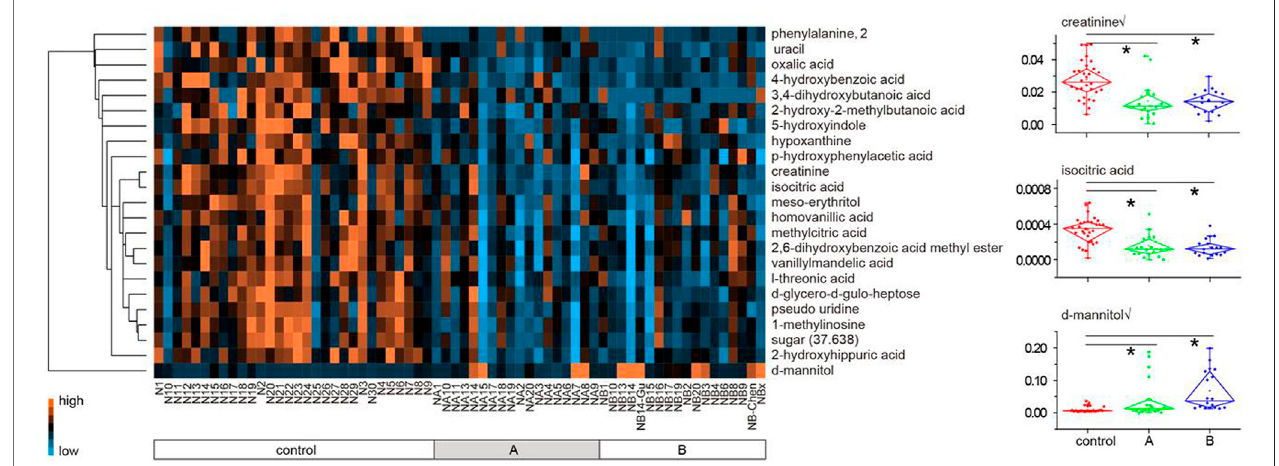
FIGURE 2 | Heat map of 23 metabolites differed between the healthy subjects and LDH patients (A plus B). Each metabolite is represented by a single row of colored boxes, and columns represent different samples. Metabolic levels are represented by different colors. The red label shows high levels in urine, while the green labels show low intensity relative to the median metabolic